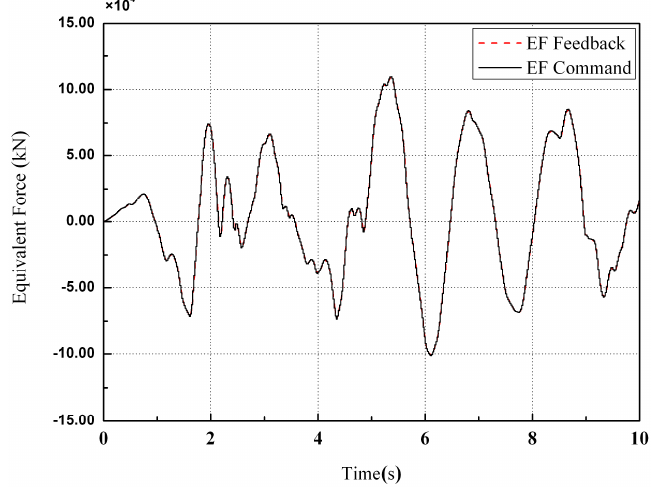
Figure 12. Comparison of the equivalent force (EF) feedback and EF command on the first floor using the non-subdivision method.